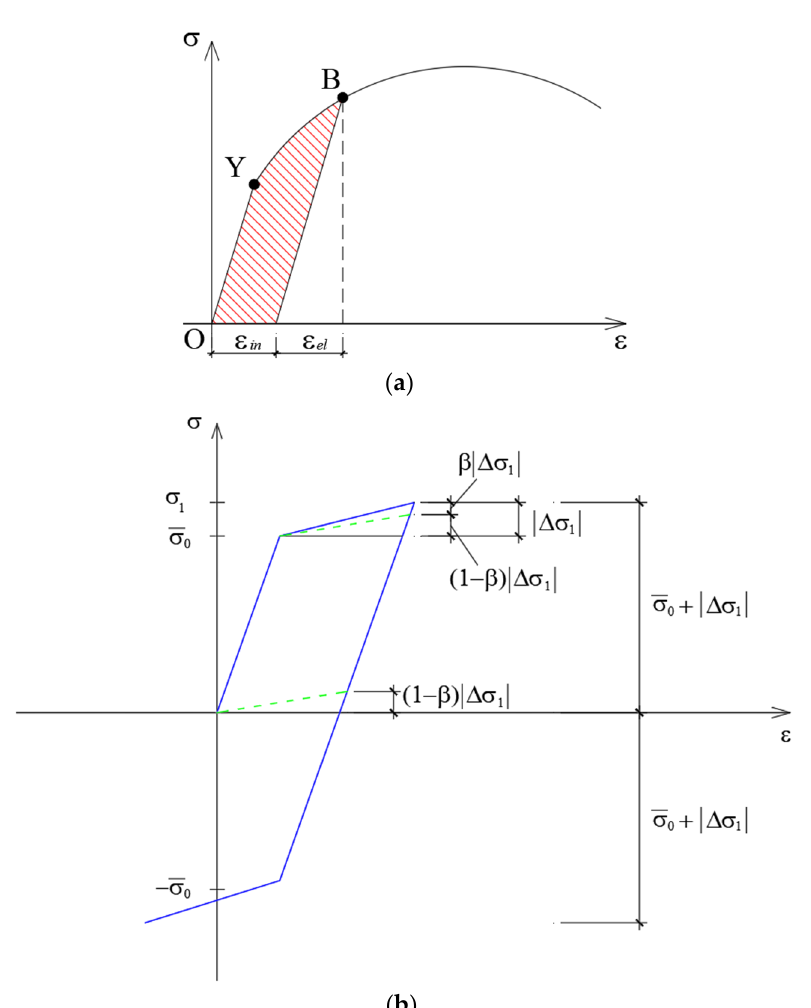
Figure 1. Material hardening laws: ( a ) Stress-strain curves; ( b ) Kinematic hardening.